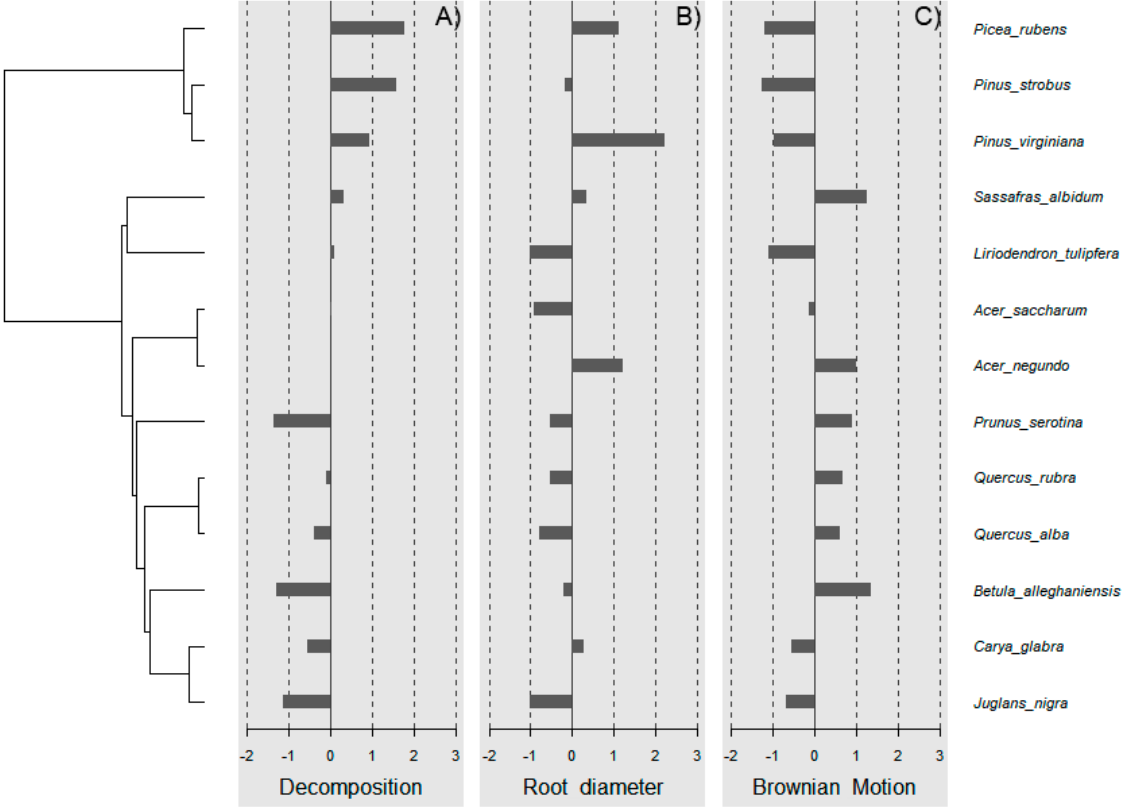
Figure 2. Testing for general phylogenetic signal. A phylogenetic signal detected for tree-soil- mediated wood decomposition ( A ) (Blomberg’s K = 1.30, Pagel’s λ = 1.00, p = 0.001). The signal was undetected or insignificant for root diameter ( B ) and Brownian motion model ( C ).